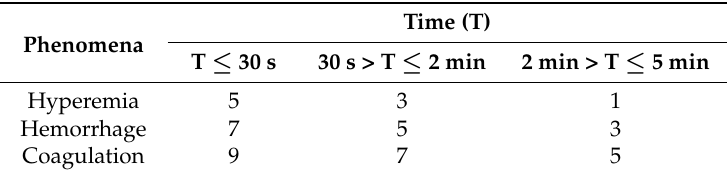
Table 1. Luepke scale for the appearance of the phenomena as function of time.